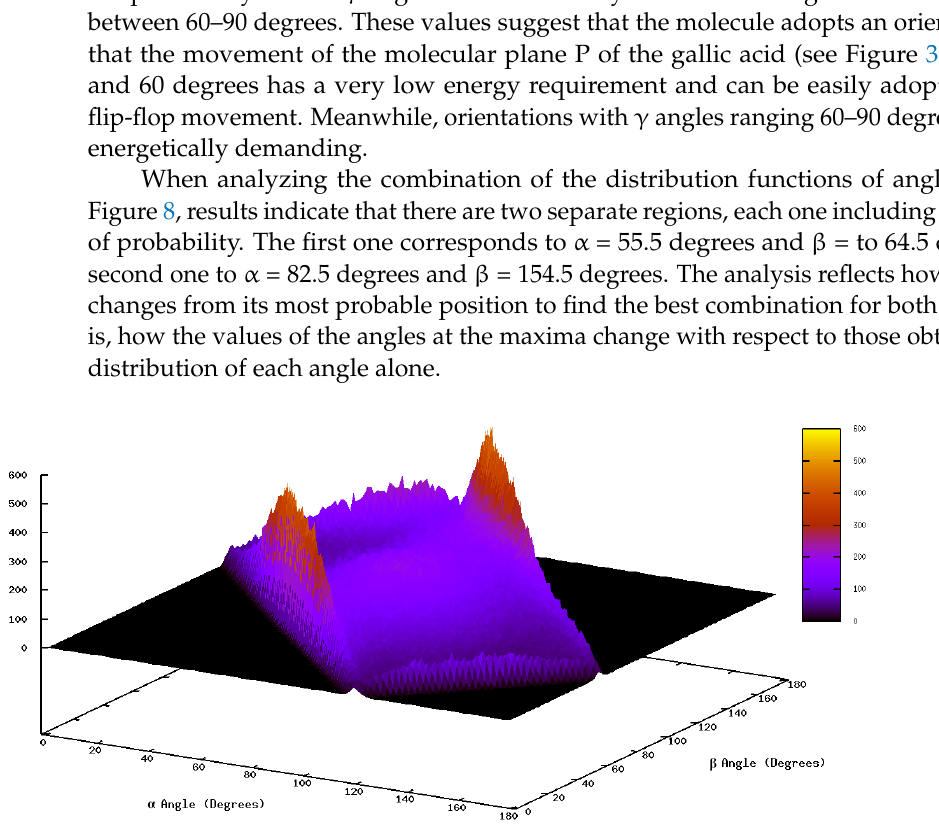
Figure 8. Probability distribution of the combination of α and β angles defined in Figure 3.